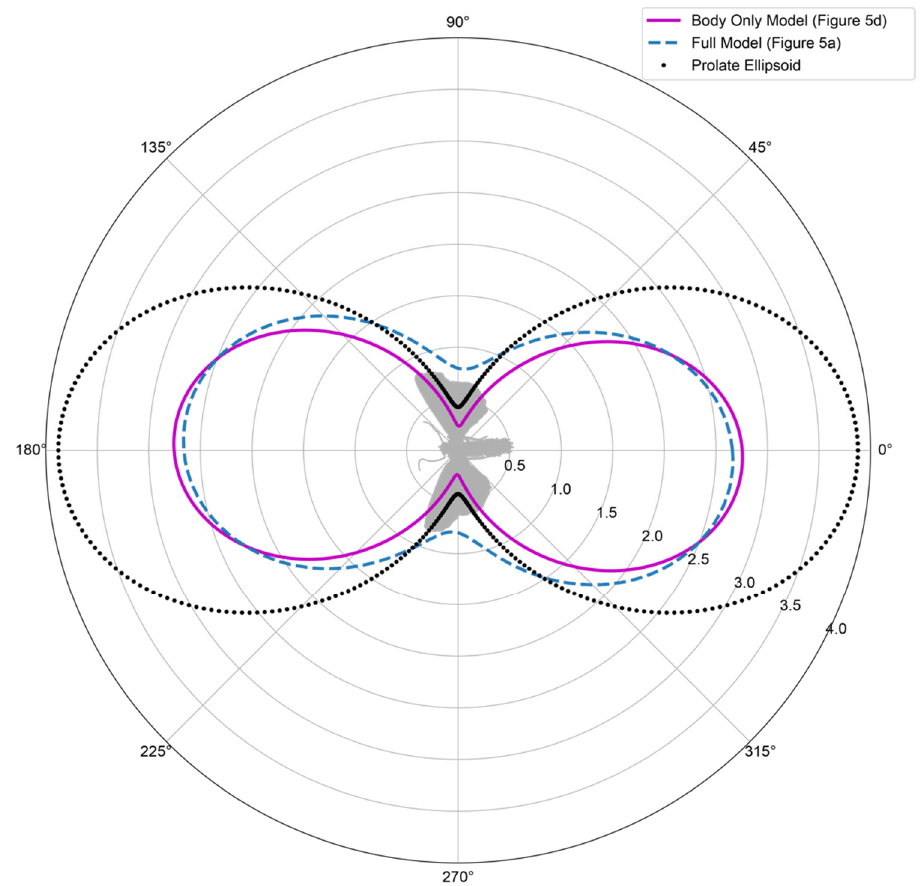
Figure 10. Comparison of the modelled polarimetric RCSs (cm 2 ) for the Body Only model (Figure 4d), the Full model (Figure 4a), and a prolate ellipsoid whose parameters where derived using Mirkovic et al. [9]. All models are based on the 25.0% decimation model in Figure 7 and use dielectric constant and density equal to that of MirkLBG. The Full model uses ChenMean as the dielectric constant for the wings, and legs and antennae (Table 1). The shadowed model is not to scale and for orientation purposes only.